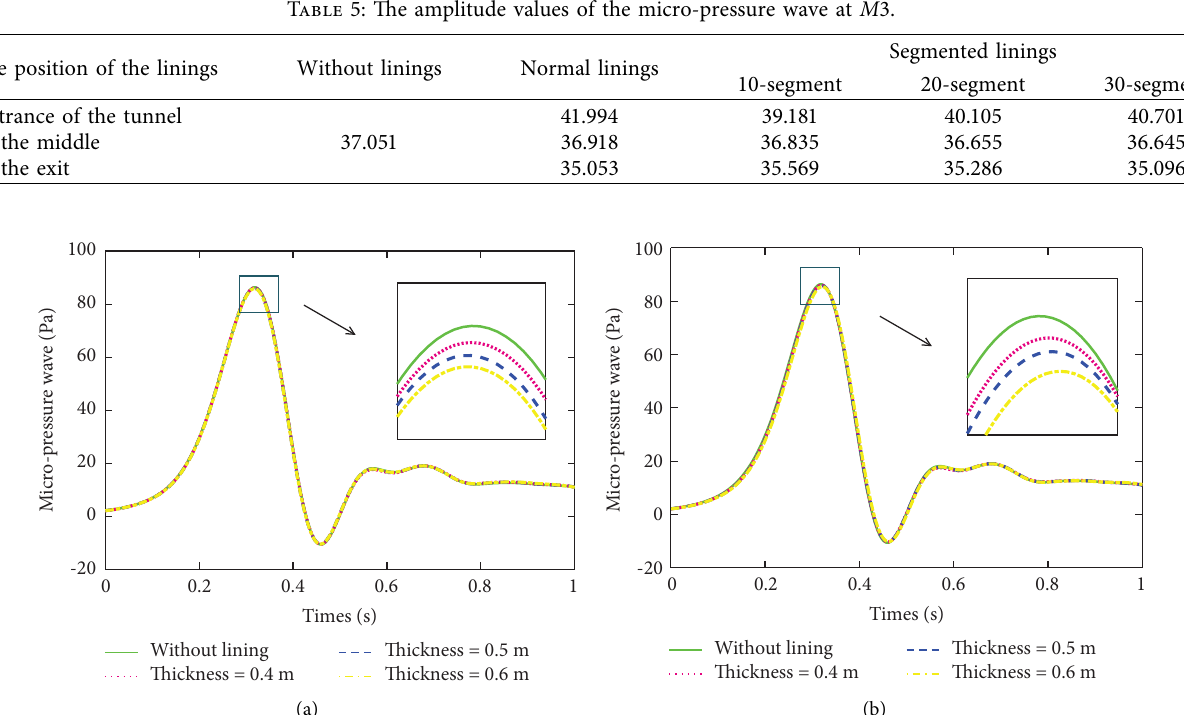
Figure 10: Comparison of the micropressure wave at M 1. (a) Normal linings. (b) 10-segment